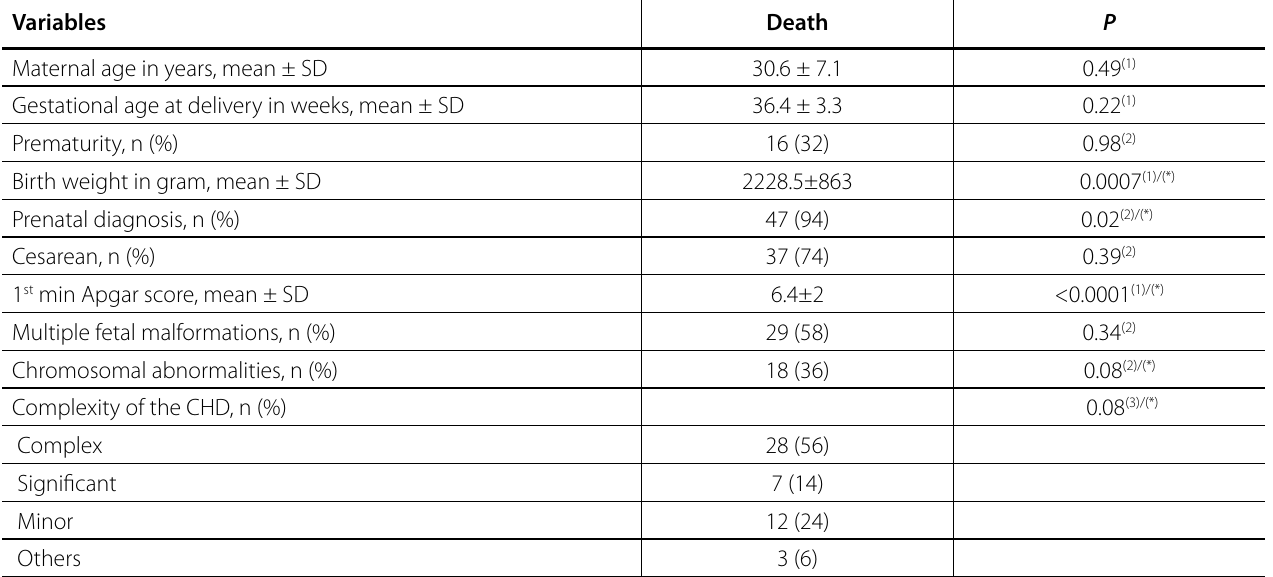
Table 4 . Mortality rates in the study population and associated factors (n=50).